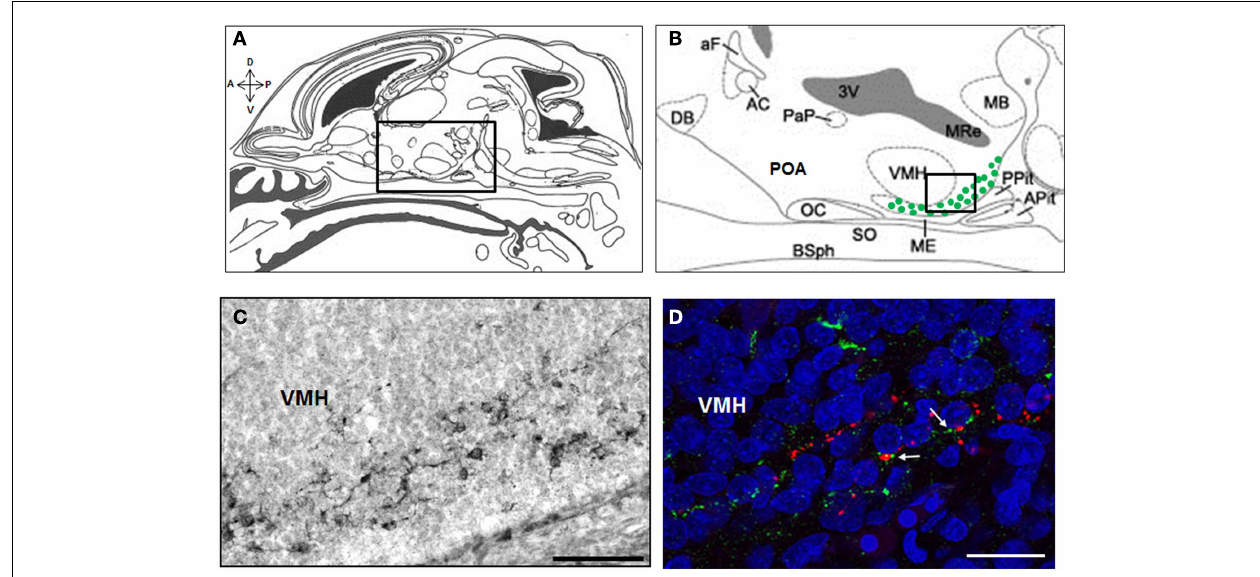
confocal optical section of a slice double immunofluorescence-labeled for kisspeptin (sheep anti-5-18 kisspeptin 52 # AC067, Desroziers et al., 2012a) and GnRH (rabbit anti-2-10 GnRH # 19900, Caldani et al., 1988) and counterstained with Hoechst nuclear marker (D) . A, anterior; P, posterior; D, dorsal;V, ventral; DB, diagonal band of Broca; aF, anterior fornix; AC, anterior commissure; PaP, paraventricular nucleus; 3V, third ventricle; OC, optic chiasma; POA, preoptic area; SO, supraoptic nucleus; ME, median eminence;VMH, ventro-medial hypothalamus; MB, mammillary bodies; Pit, pituitary; Apit, anterior pituitary; Ppit, posterior pituitary; BSph, sphenoid bones; MRe, mammillary recess. Scale bars: 100 µ m (C) and 20 µ m (D)